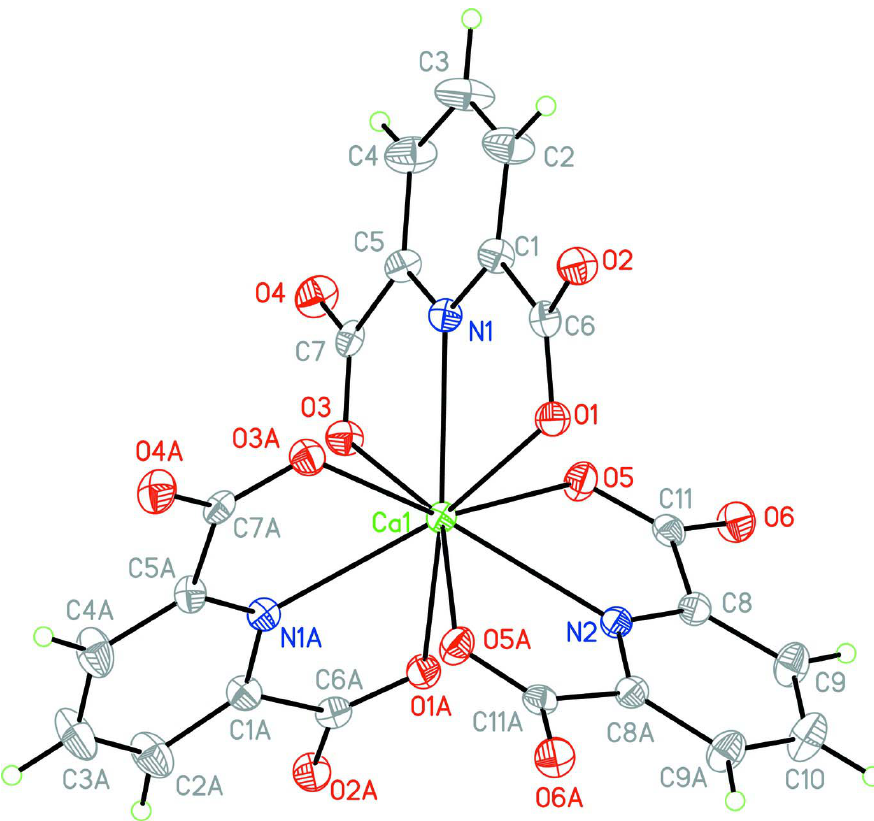
Figure 1 The molecular structure of the title compound, with displacement ellipsoids drawn at the 50% probability level. The anion is located on a 2-fold axis and thus, the asymmetric unit contains one half anion, two cations and three water